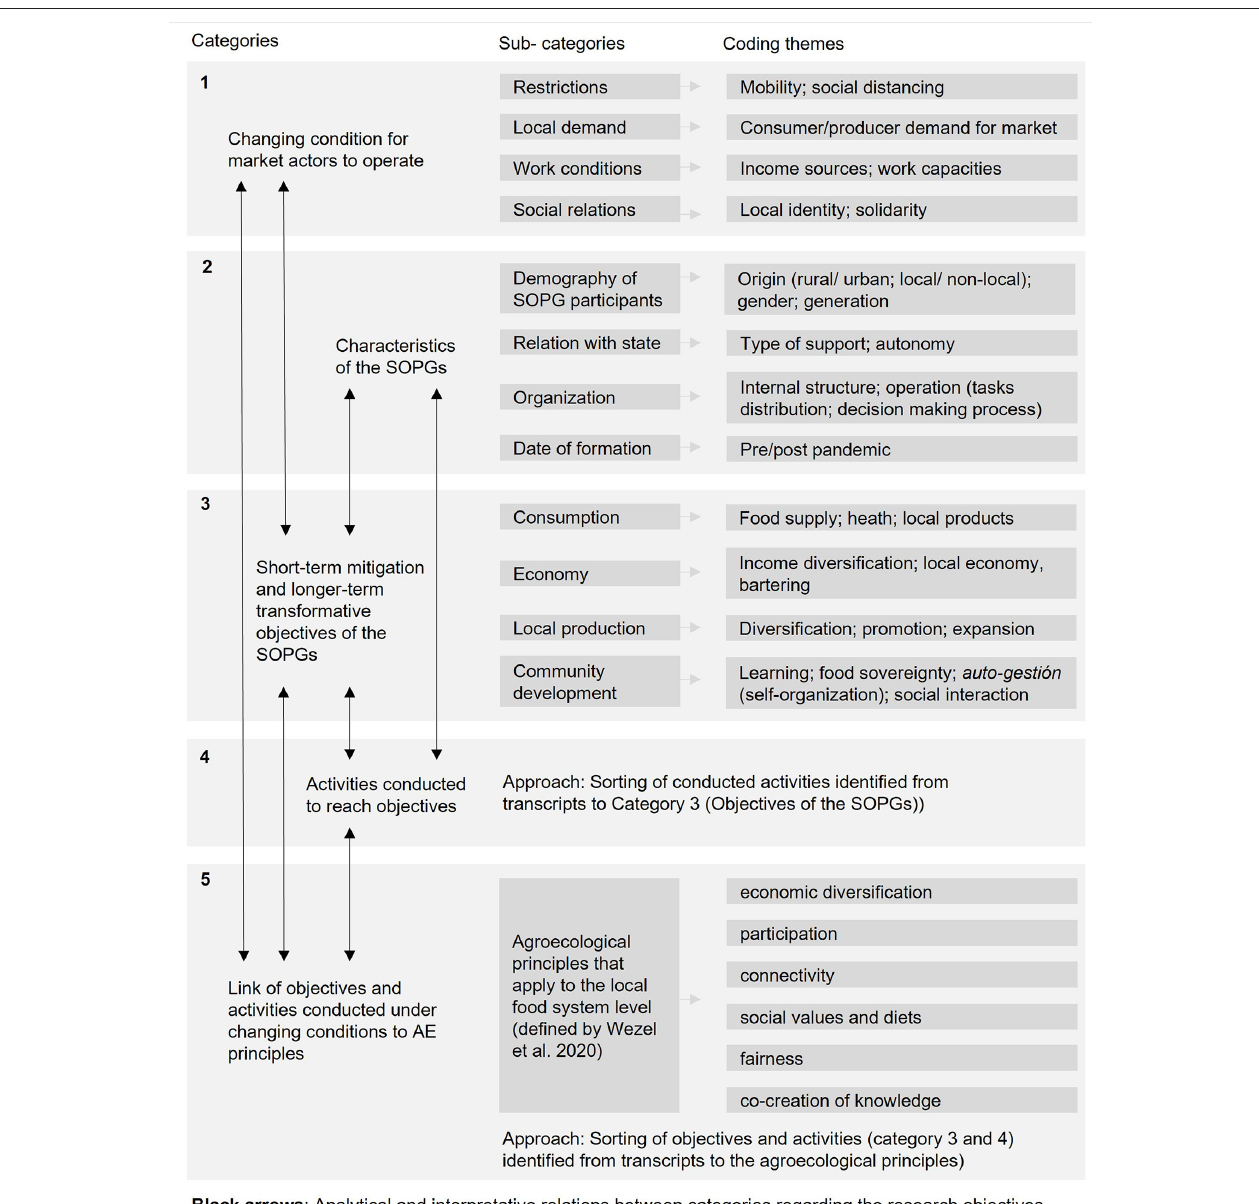
FIGURE 2 | Qualitative content analysis